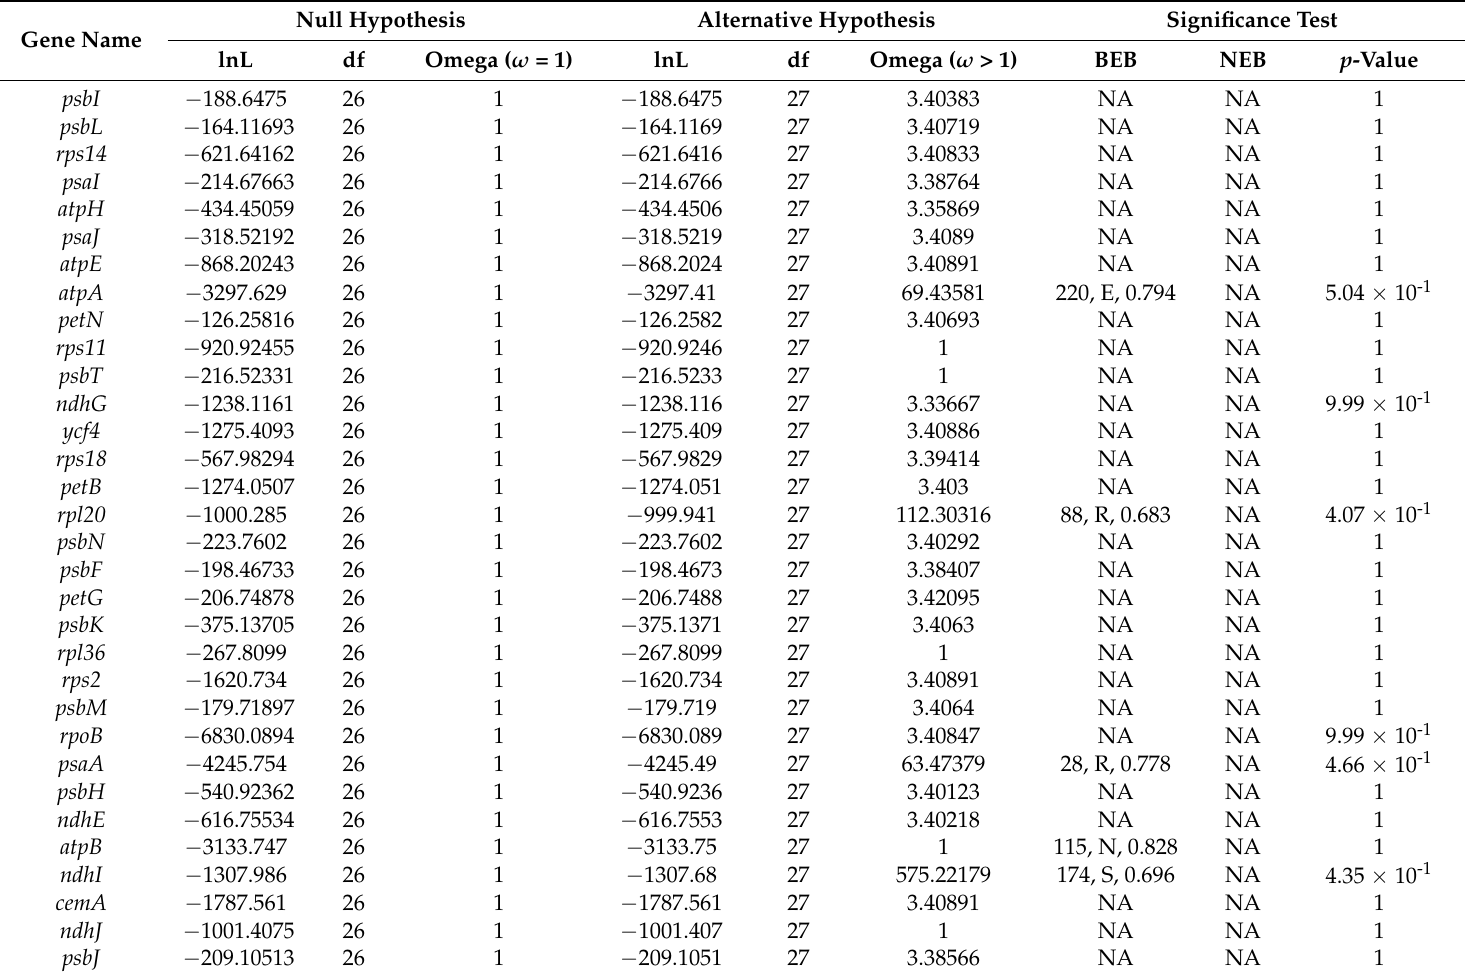
Table 4. The potential positive selection test based on the branch-site